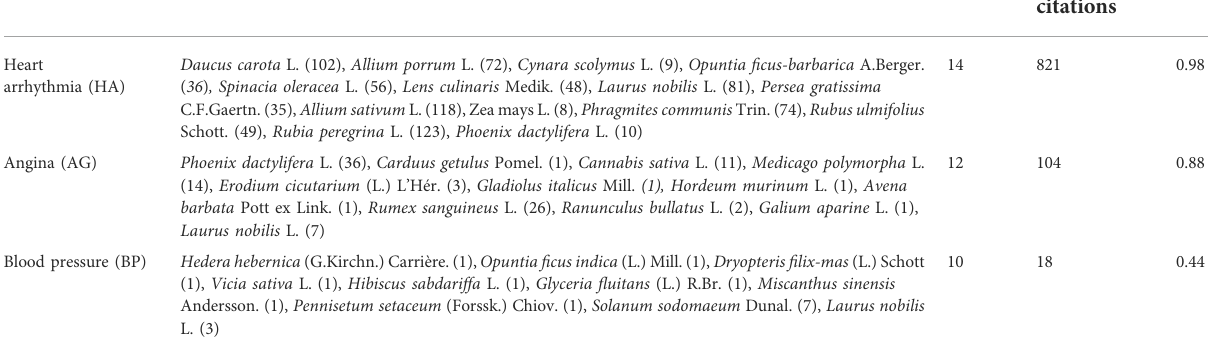
TABLE 3 ICF values by categories for treating cardiovascular diseases. Categories List of plant species used and number of